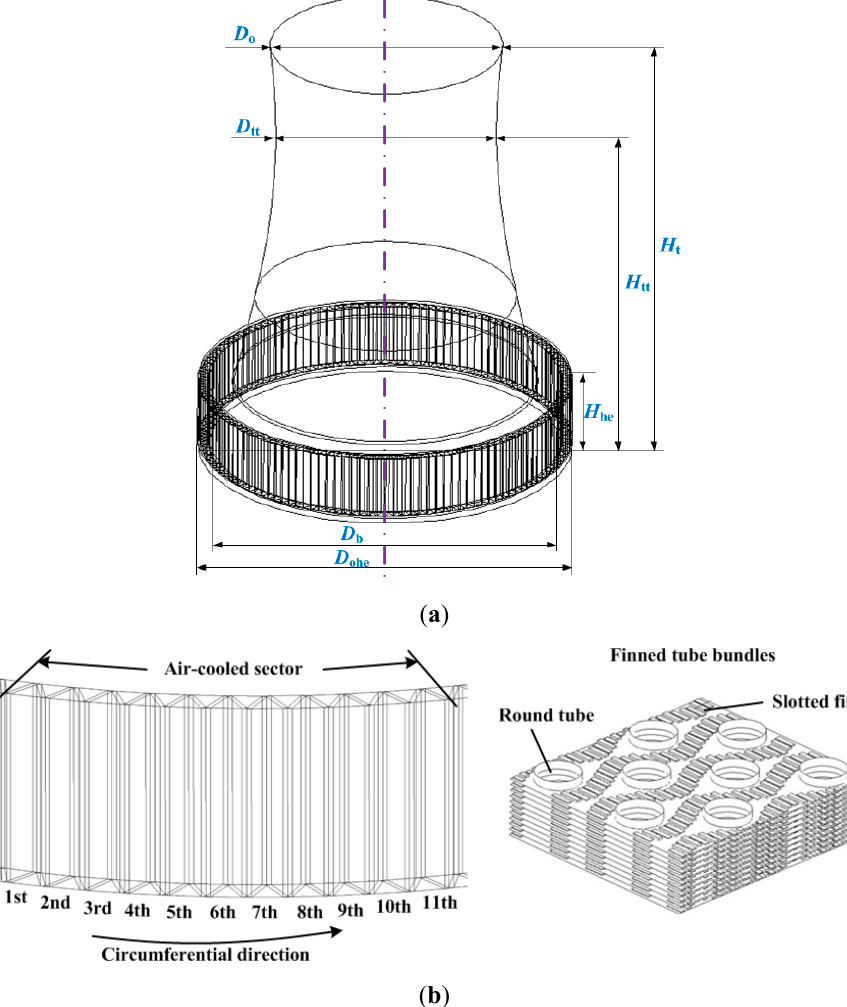
Figure 1. Geometric schematics of natural draft dry cooling system. ( a ) Dry cooling tower and vertically arranged heat exchanger, ( b ) cooling deltas and slotted finned tubes. Energies 2019 , 12 , x FOR PEER REVIEW 5 of 32